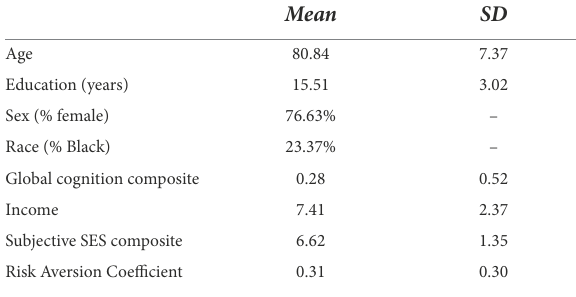
TABLE 2 Distribution of participant characteristics and subjective SES composite score ( N = 933).